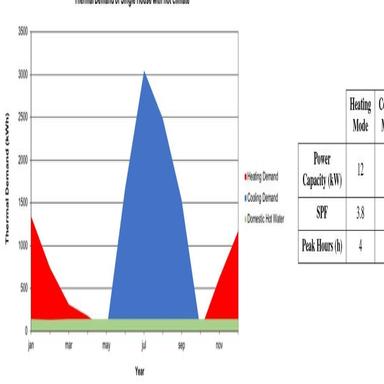
Thermal loads for a single house in a hot climatic region.